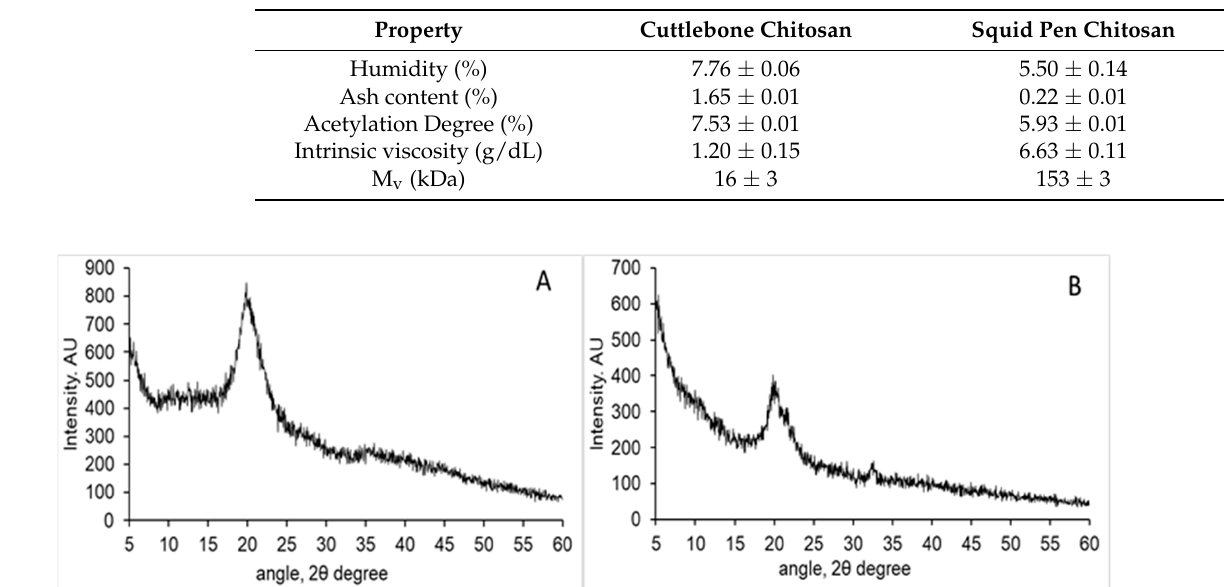
Table 2. Chitosan Characterization.